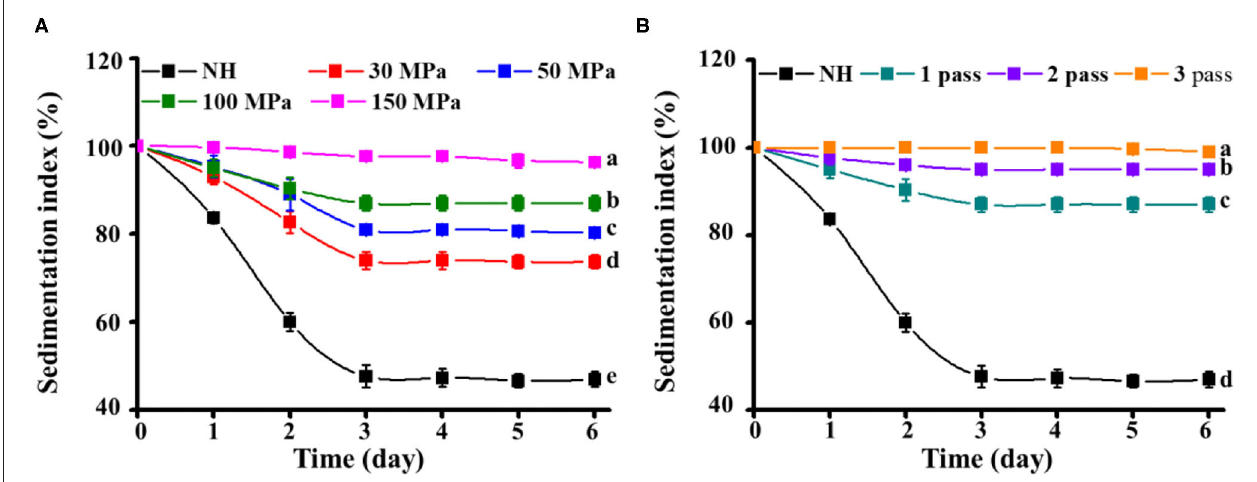
FIGURE 3 | Effect of HPH treatments on the sedimentation index of NFC orange juice. (A) Homogenization pressure; (B) Homogenization